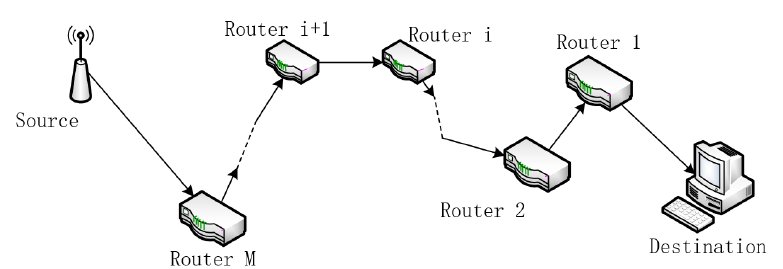
Figure 1. Network model. The data packets generated by sources such as sensors are relayed one by one in a serial manner through multiple wireless routers and finally delivered to the